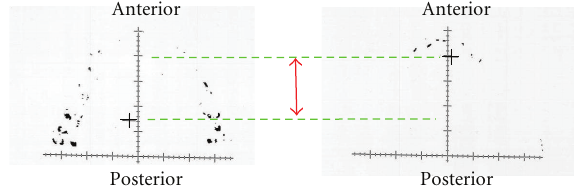
Figure 6: A cross represents the COL in the upper dentition during maximum clenching.